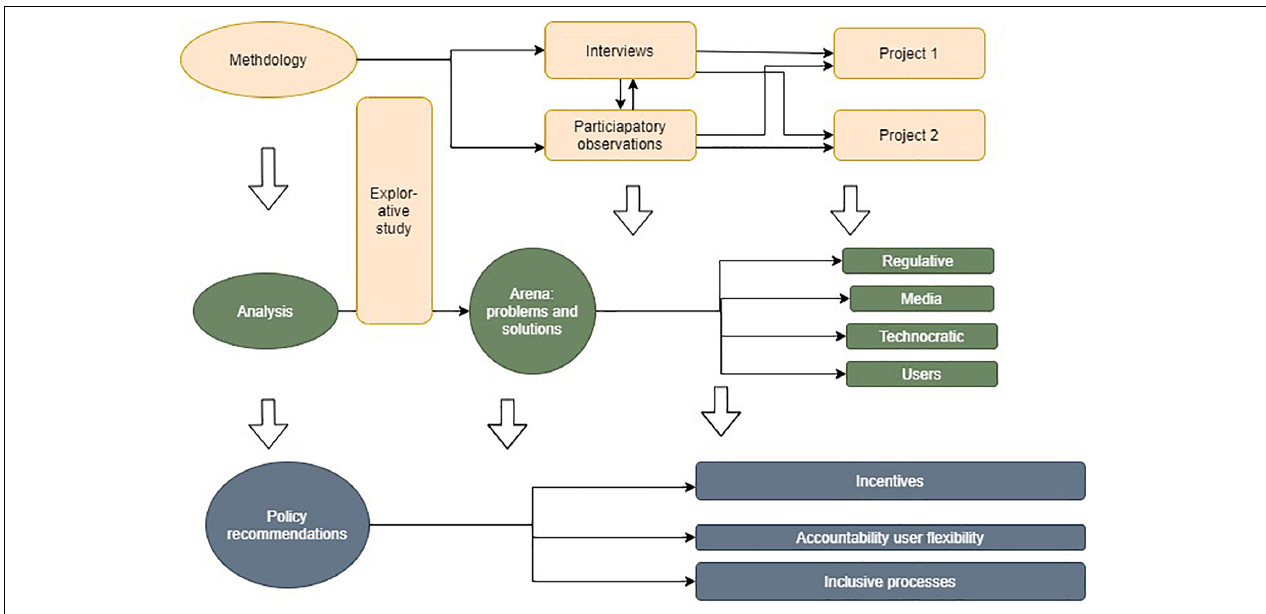
FIGURE 1 | The research process of this